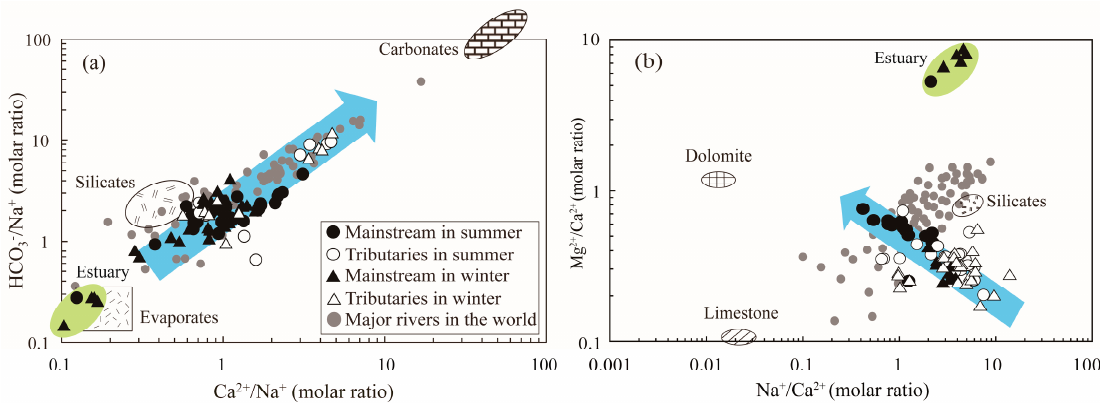
Figure 5. ( a ) Relationship between HCO − /Na + and Ca 2 + /Na + (molar ratios), ( b ) Plots of Na + /Ca 2 + and Mg 2 + /Ca 2 + (molar ratios) for river waters in the JR. Gray dots are the major rivers in the world [16]. End members in ( a ) are from Gaillardet, Dupre, Louvat and Allegre [16], and those of ( b ) are from Han and Liu [32].